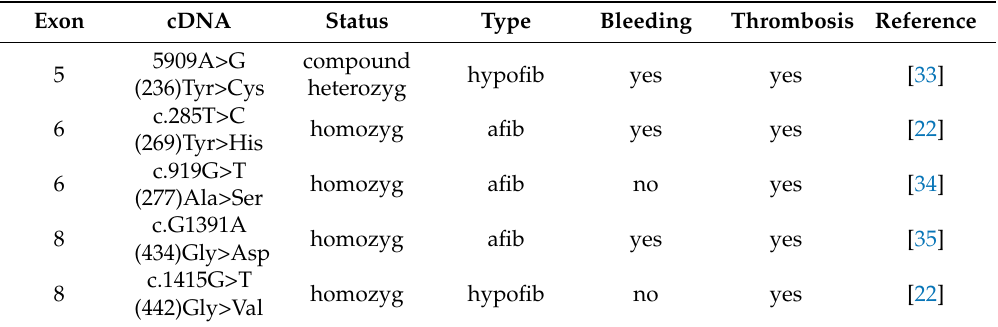
Table 4. Missense mutations in the FGB